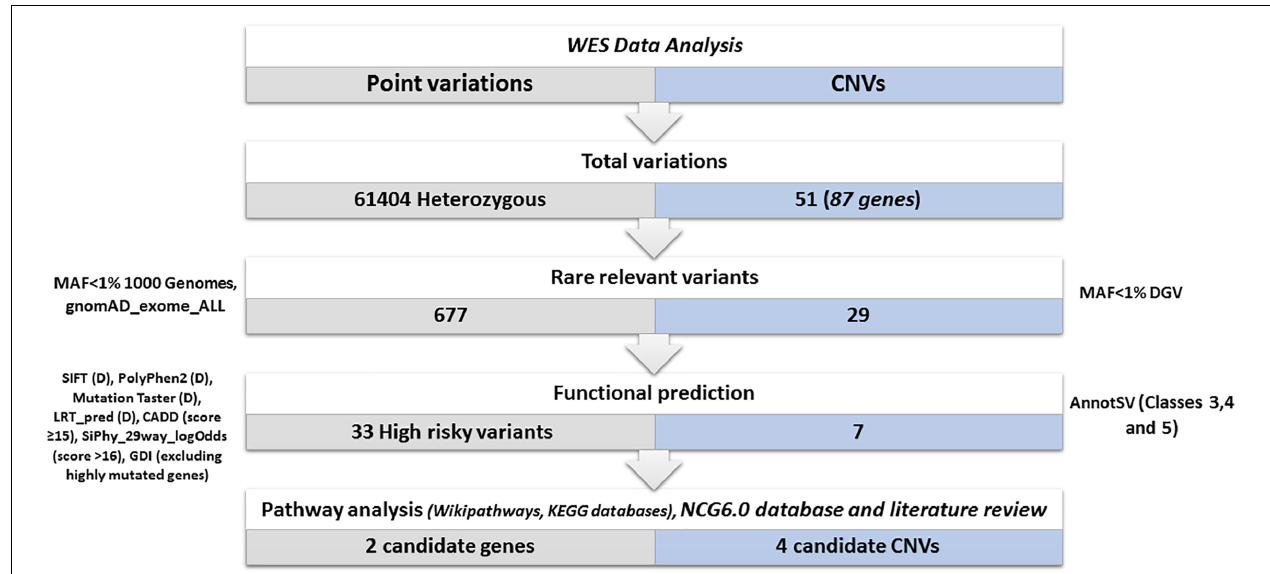
FIGURE 4 | Variants prioritization. Total variations: represents the total number of the identified heterozygous variants and CNVs. Rare relevant variants: we kept (exonic, splicing, non-synonymous, frameshift Indels, stop gain, stop loss) variants. We excluded variants with a frequency > 1% in 1000 genomes and gnomAD_Exome databases and CNVs with a frequency > 1% in DGV. Functional prediction: using several prediction tools: SIFT (Deleterious), PolyPhen2 (Probably damaging), Mutation Taster (disease-causing), LRT_pred (Deleterious), CADD (score ≥ 15), SiPhy_29way_logOdds (score > 16), GDI database (excluding